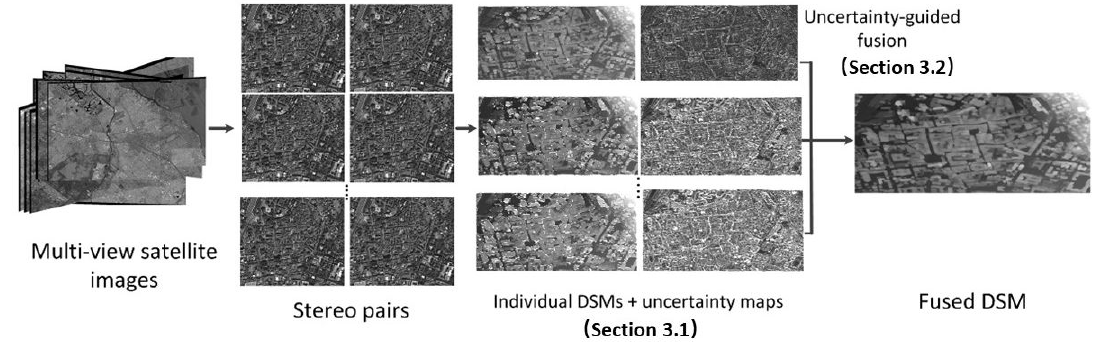
Figure 1. Workflow of the proposed depth fusion